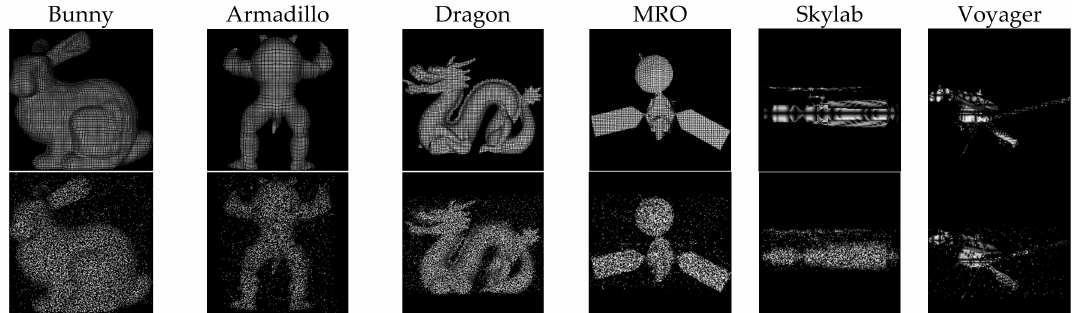
Figure 4. The point clouds with added Gaussian noise and outliers: The point clouds in the first row are the original point clouds, the second row are the first row with added outliers and noise.